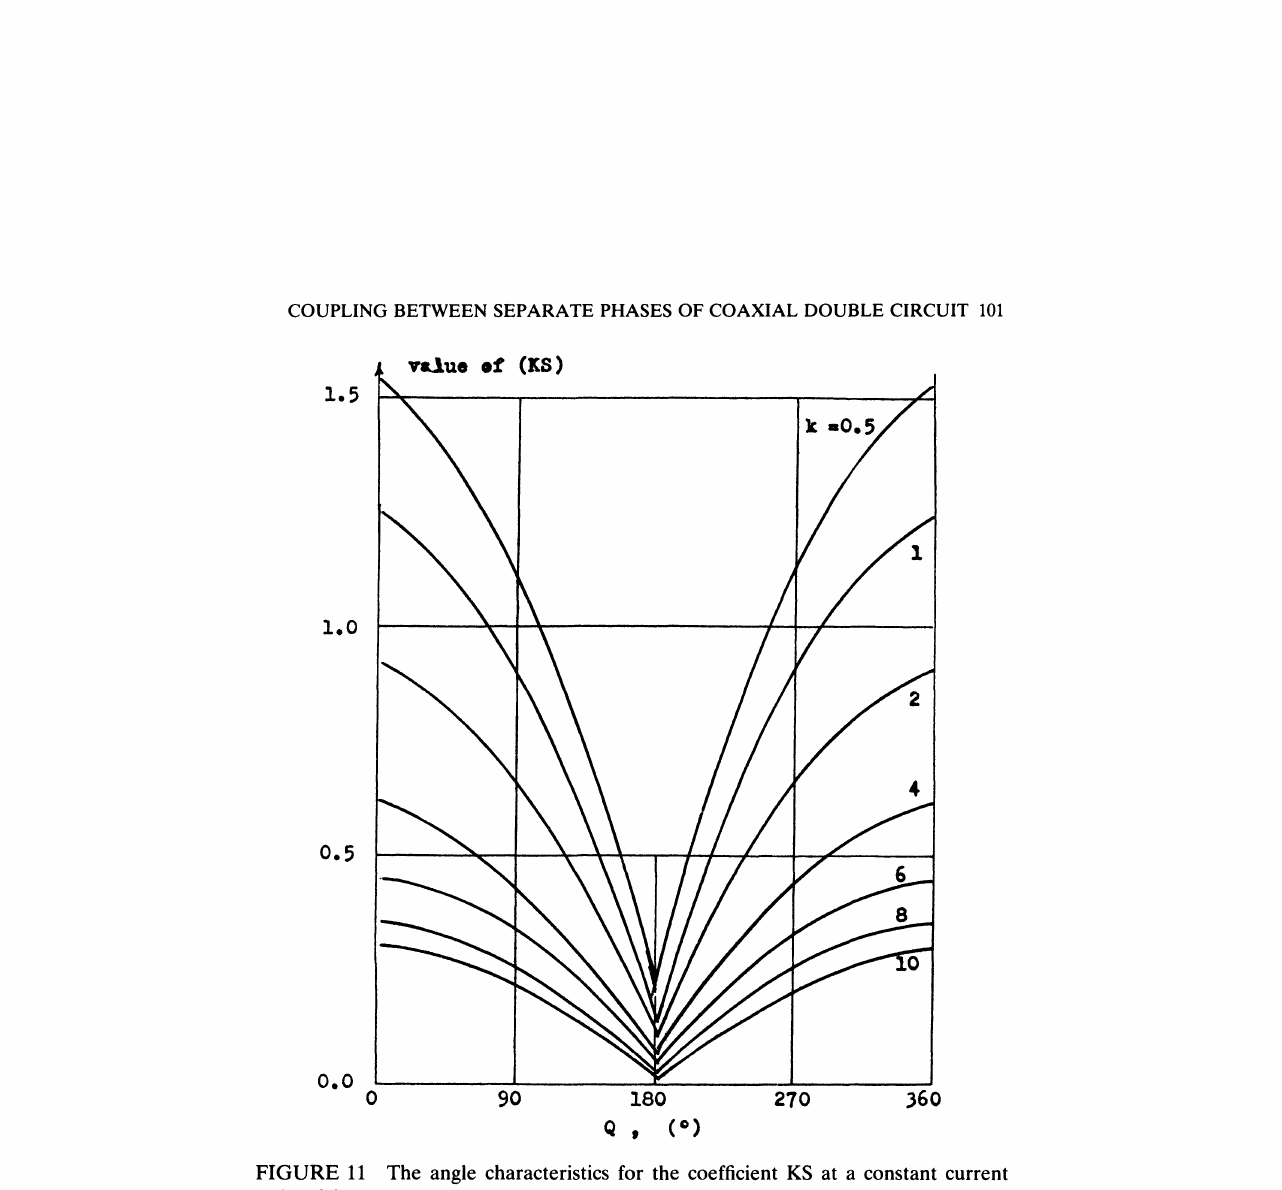
FIGURE 11 The angle characteristics for the coefficient KS at a constant current ratio of